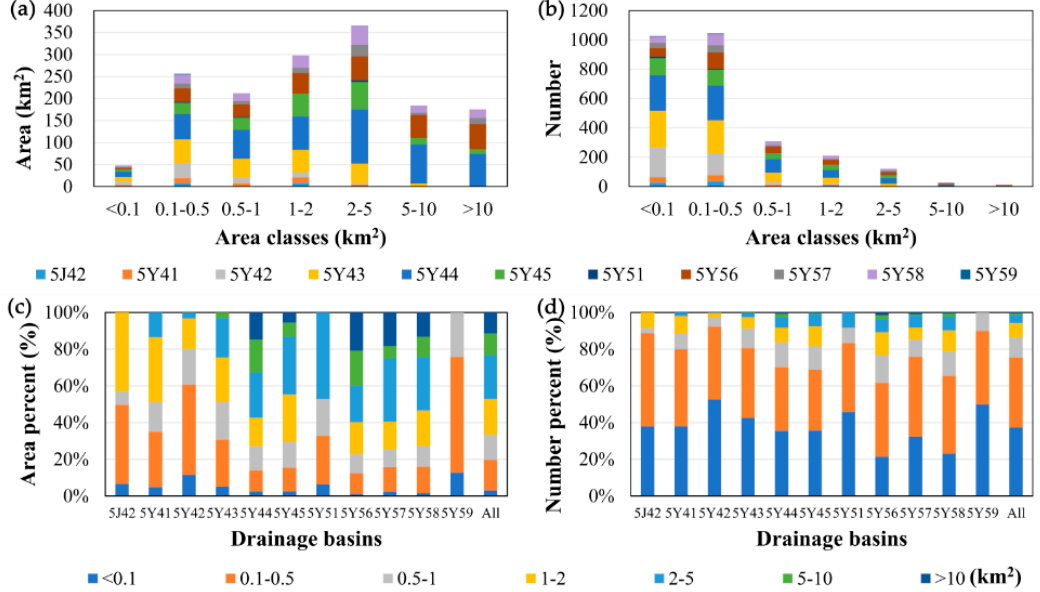
Figure 2. Total glaciers areas ( a ) and numbers ( b ) of the 2015 inventory and their respective proportions ( c , d ) within different area classes and different drainage basins.